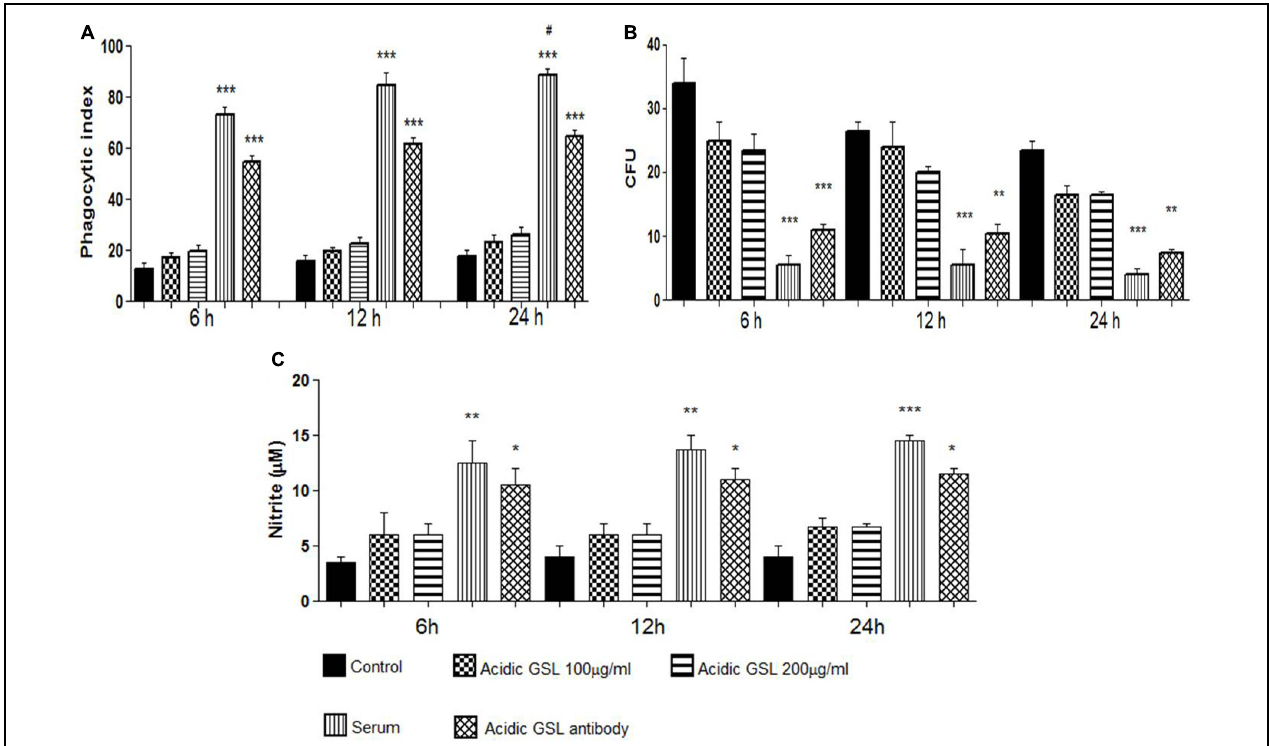
FIGURE 2 | Experiments in vitro: (A) Phagocytosis of yeast cells by J774.16 cells in the presence of polyclonal antibodies to acidic GSL, polyclonal antibodies to BSA (control), total serum with different polyclonal antibodies and purified acidic GSLs, 100 and 200 µ g. Each bar represents the average of three measurements. Experiments were done in triplicate, and different fields were counted. Significant difference ( ∗ p < 0.05, ∗∗ p < 0.01, ∗∗∗ p < 0.0001). (B) Killing assay using peritoneal macrophages in the phagocytosis assay. Polyclonal antibodies against BSA (control), purified acidic GSL, total serum with different polyclonal antibodies, polyclonal anti-acidic GSL antibody. The columns represent the mean average of three readings. Significant values compared to controls, ∗∗∗ p < 0.0001, ∗∗ p < 0.01. (C) Nitric oxide formed in J774.16 cells cultured with P. brasiliensis yeasts. Polyclonal antibodies to acidic GSL, polyclonal antibodies to BSA (control), total serum with different polyclonal antibodies, purified acidic GSLs. Nitrite was determined by Griess reagent. Significant difference ( ∗ p < 0.05, ∗∗ p < 0.01, ∗∗∗ p < 0.0001). # p < 0.05 (student’s t -test).